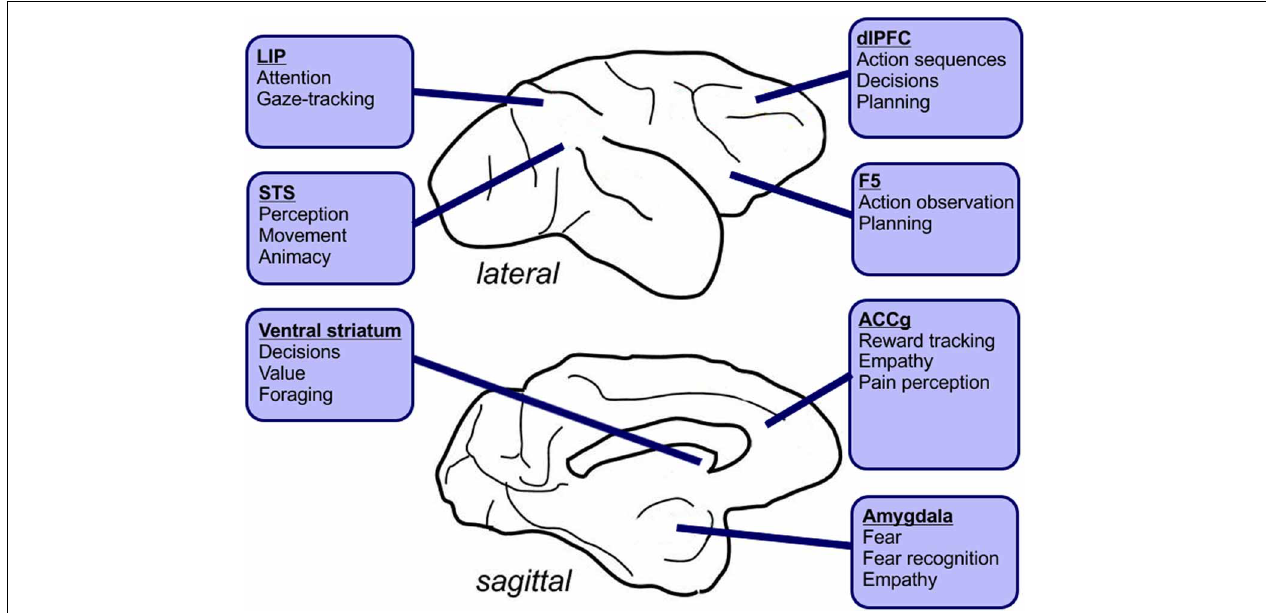
FIGURE 3 | Hypothetical roles for macaque brain areas known to be involved in social interactions, planning and perception. Social learning may involve directing attention at others or tracking their gaze. It may also involve observing their behaviors and emulating or imitating sequences of